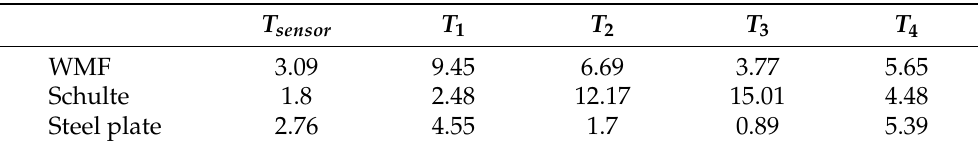
Table 5. MAE of the two models modelled with Model II. T sensor , T 1 , T 2 , T 3 and T 4 are the thermocou- ples in Figure 1b. The units are ◦